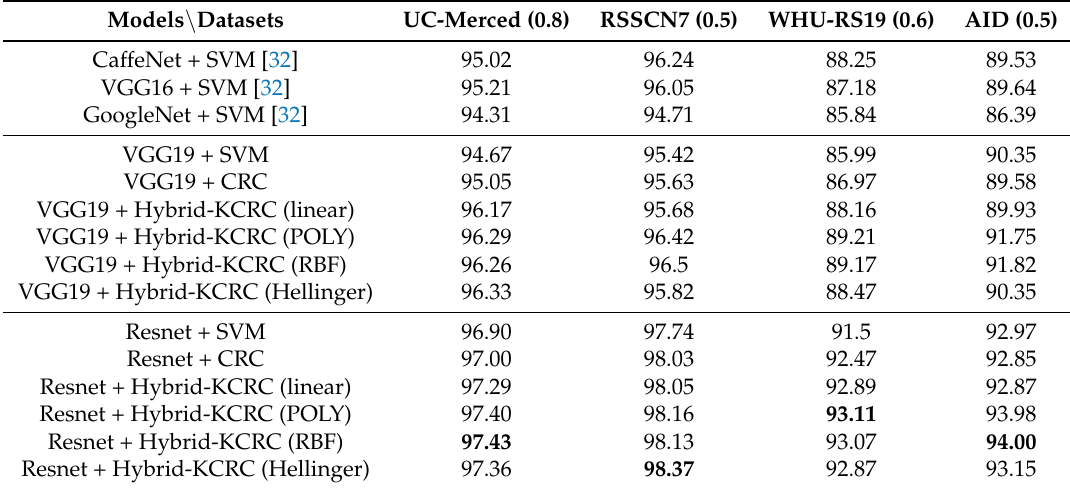
Table 6. Comparison with different CNN pretrained models